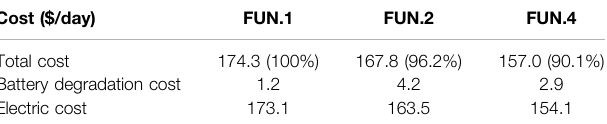
TABLE 2 | Operation cost of station between different functionalities. Cost